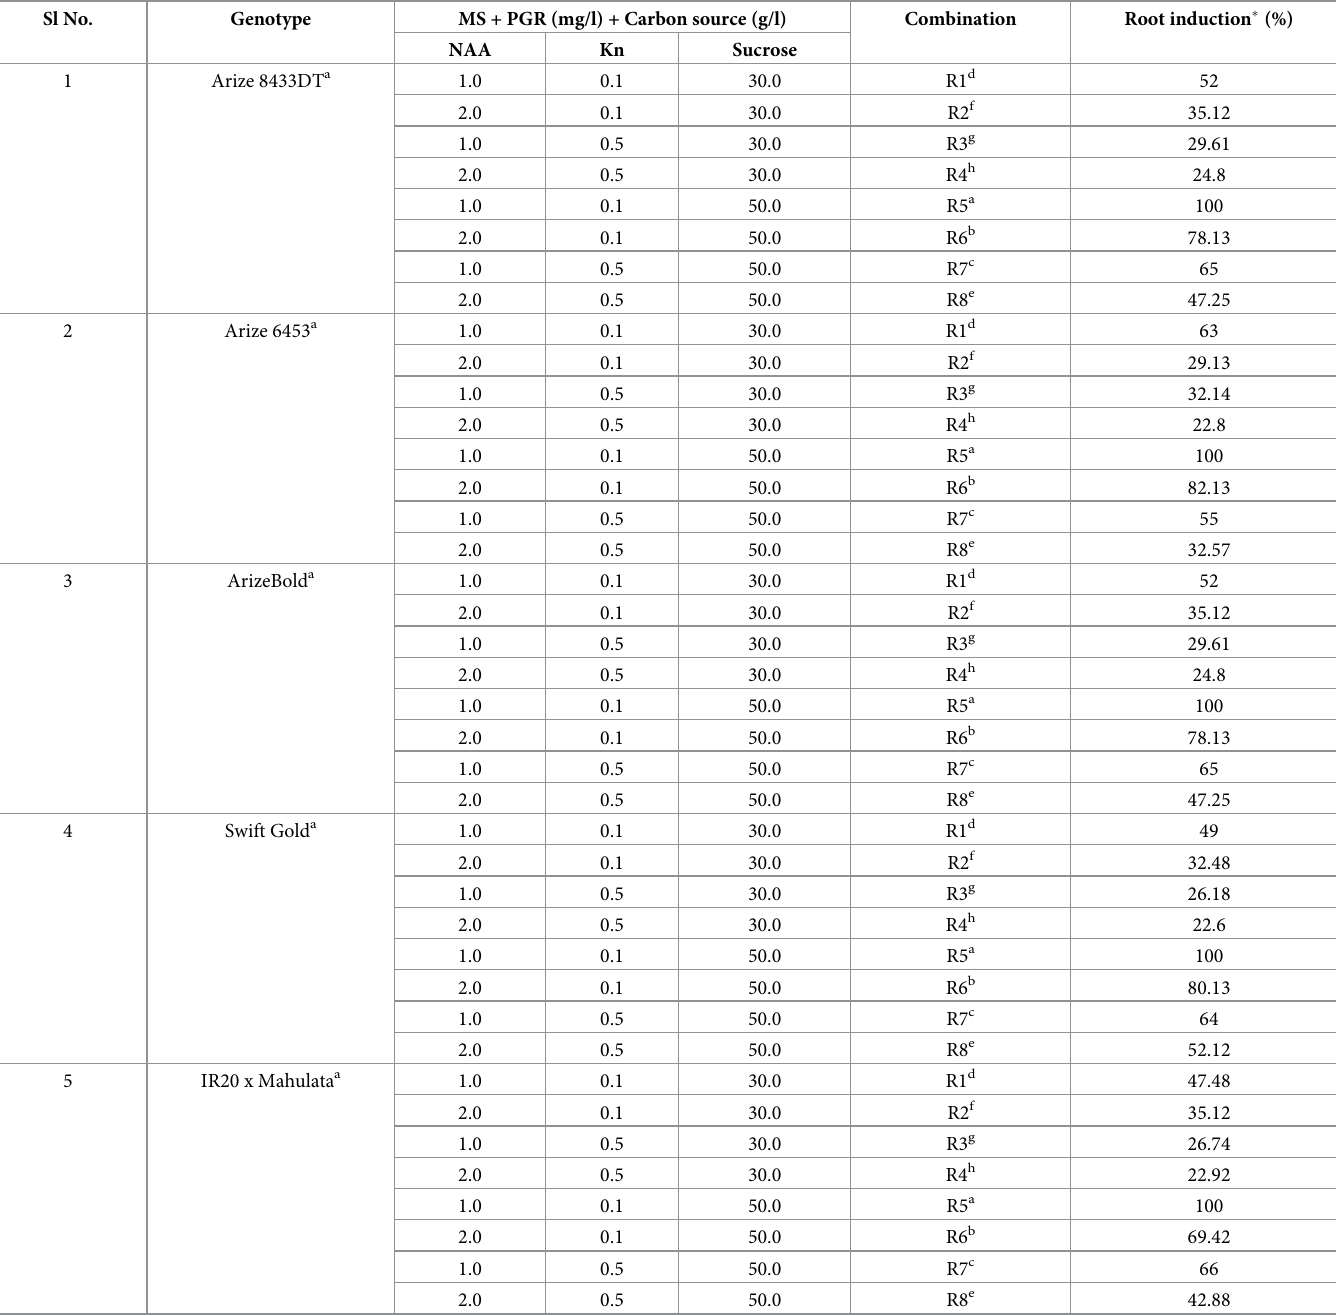
Table 5. MS based rooting medium efficiency. Sl